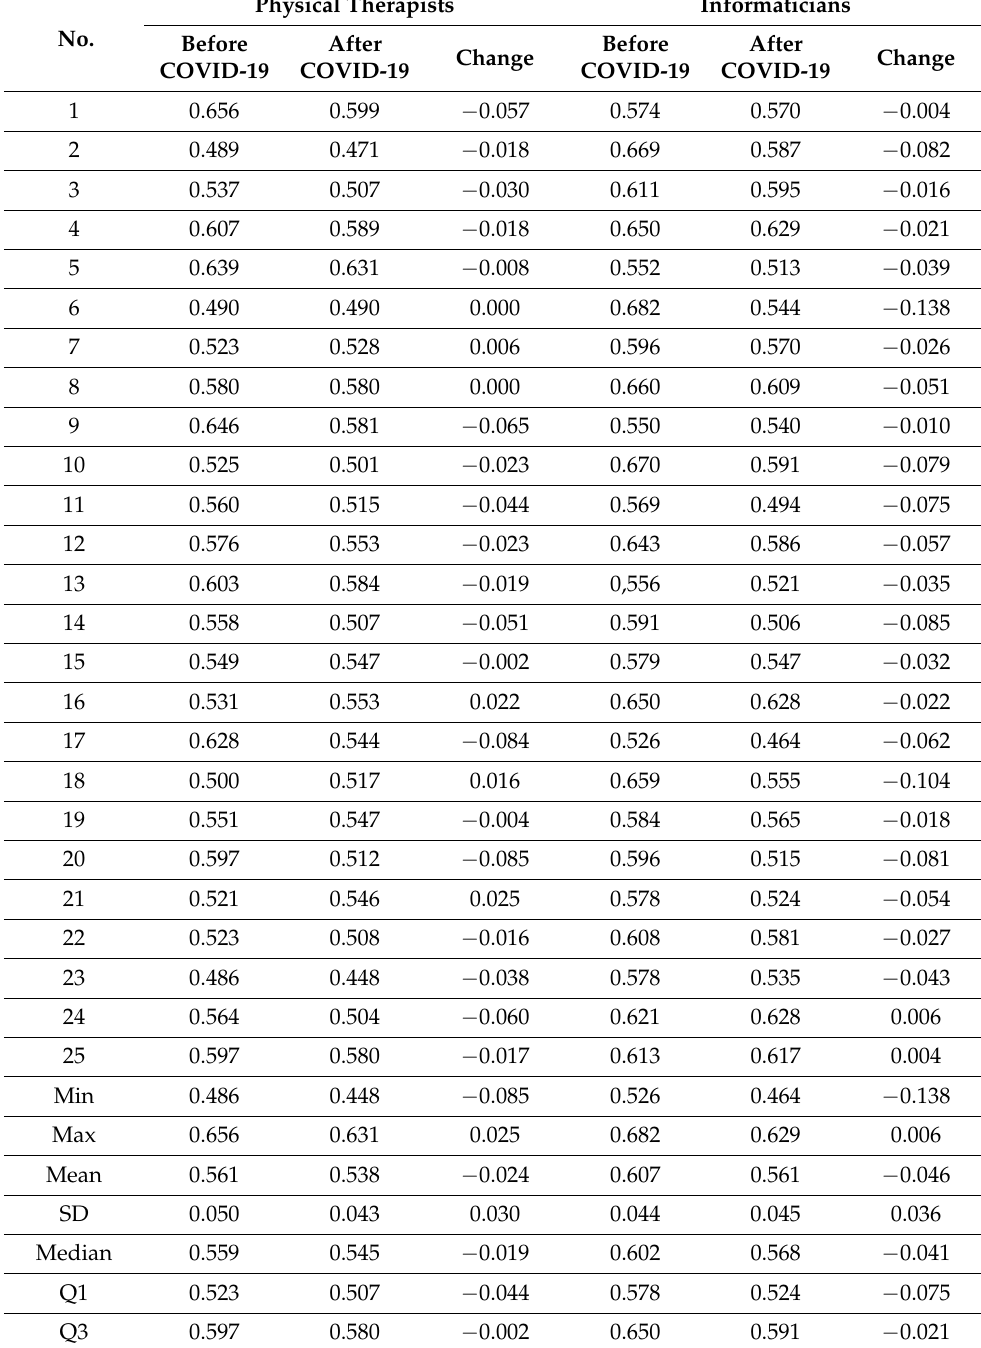
Table 8. Fuzzy models: Model 2, groups 1 and